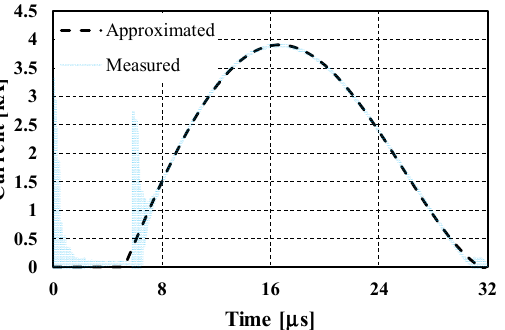
Figure 5. Measured waveform of injected current having a magnitude of about 4 kA, and the approximated waveform used in the FDTD calculation.